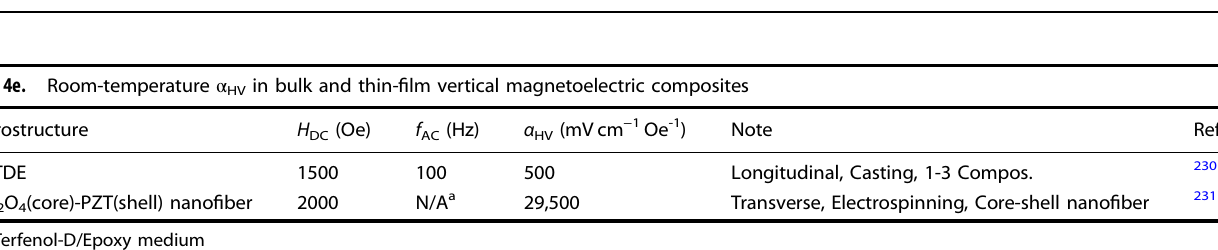
Table 4d. Room-temperature α HV in thin- fi lm horizontal magnetoelectric composites Heterostructure